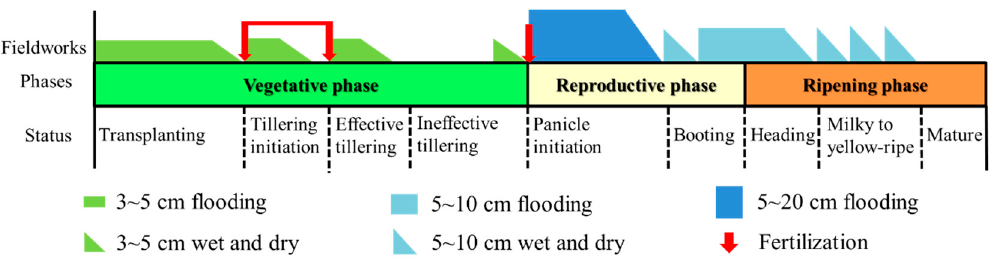
Figure 2. Common practices of rice cultivation in Taiwan.